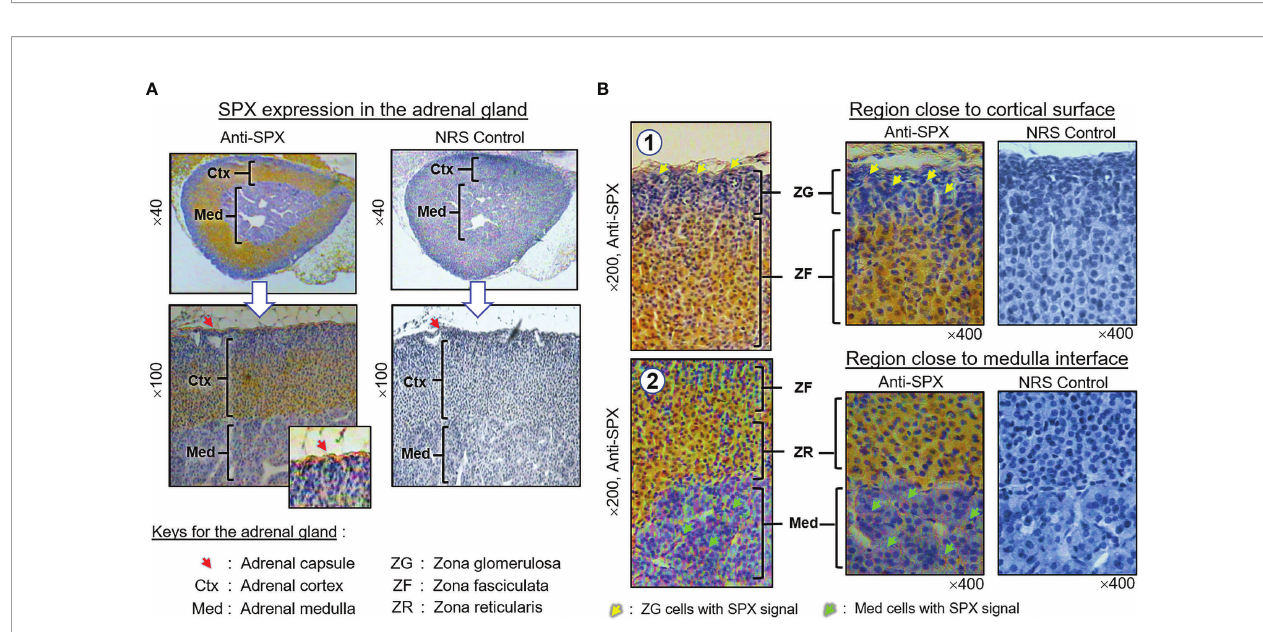
FIGURE 7 | Histological distribution of SPX expression in the adrenal gland. (A) SPX immunoreactivity detected by anti-SPX in different regions of the mouse adrenal, including the adrenal capsule, outer cortex and inner medulla. (B) SPX expression in different cell layers of the outer cortex and within the inner medulla. In outer cortex, SPX signals were detected in adrenocortical cells of zona glomerulosa, zona fasciculata and zona reticularis, respectively. Faint signals of SPX immunostaining could also be noted in chromaf fi n cells of the inner medulla. In this study, parallel staining with NRS was used as the negative control and the numbers shown on the side/in the bottom (×40, ×100, ×200, and ×400) represent the magni fi cation for the respective